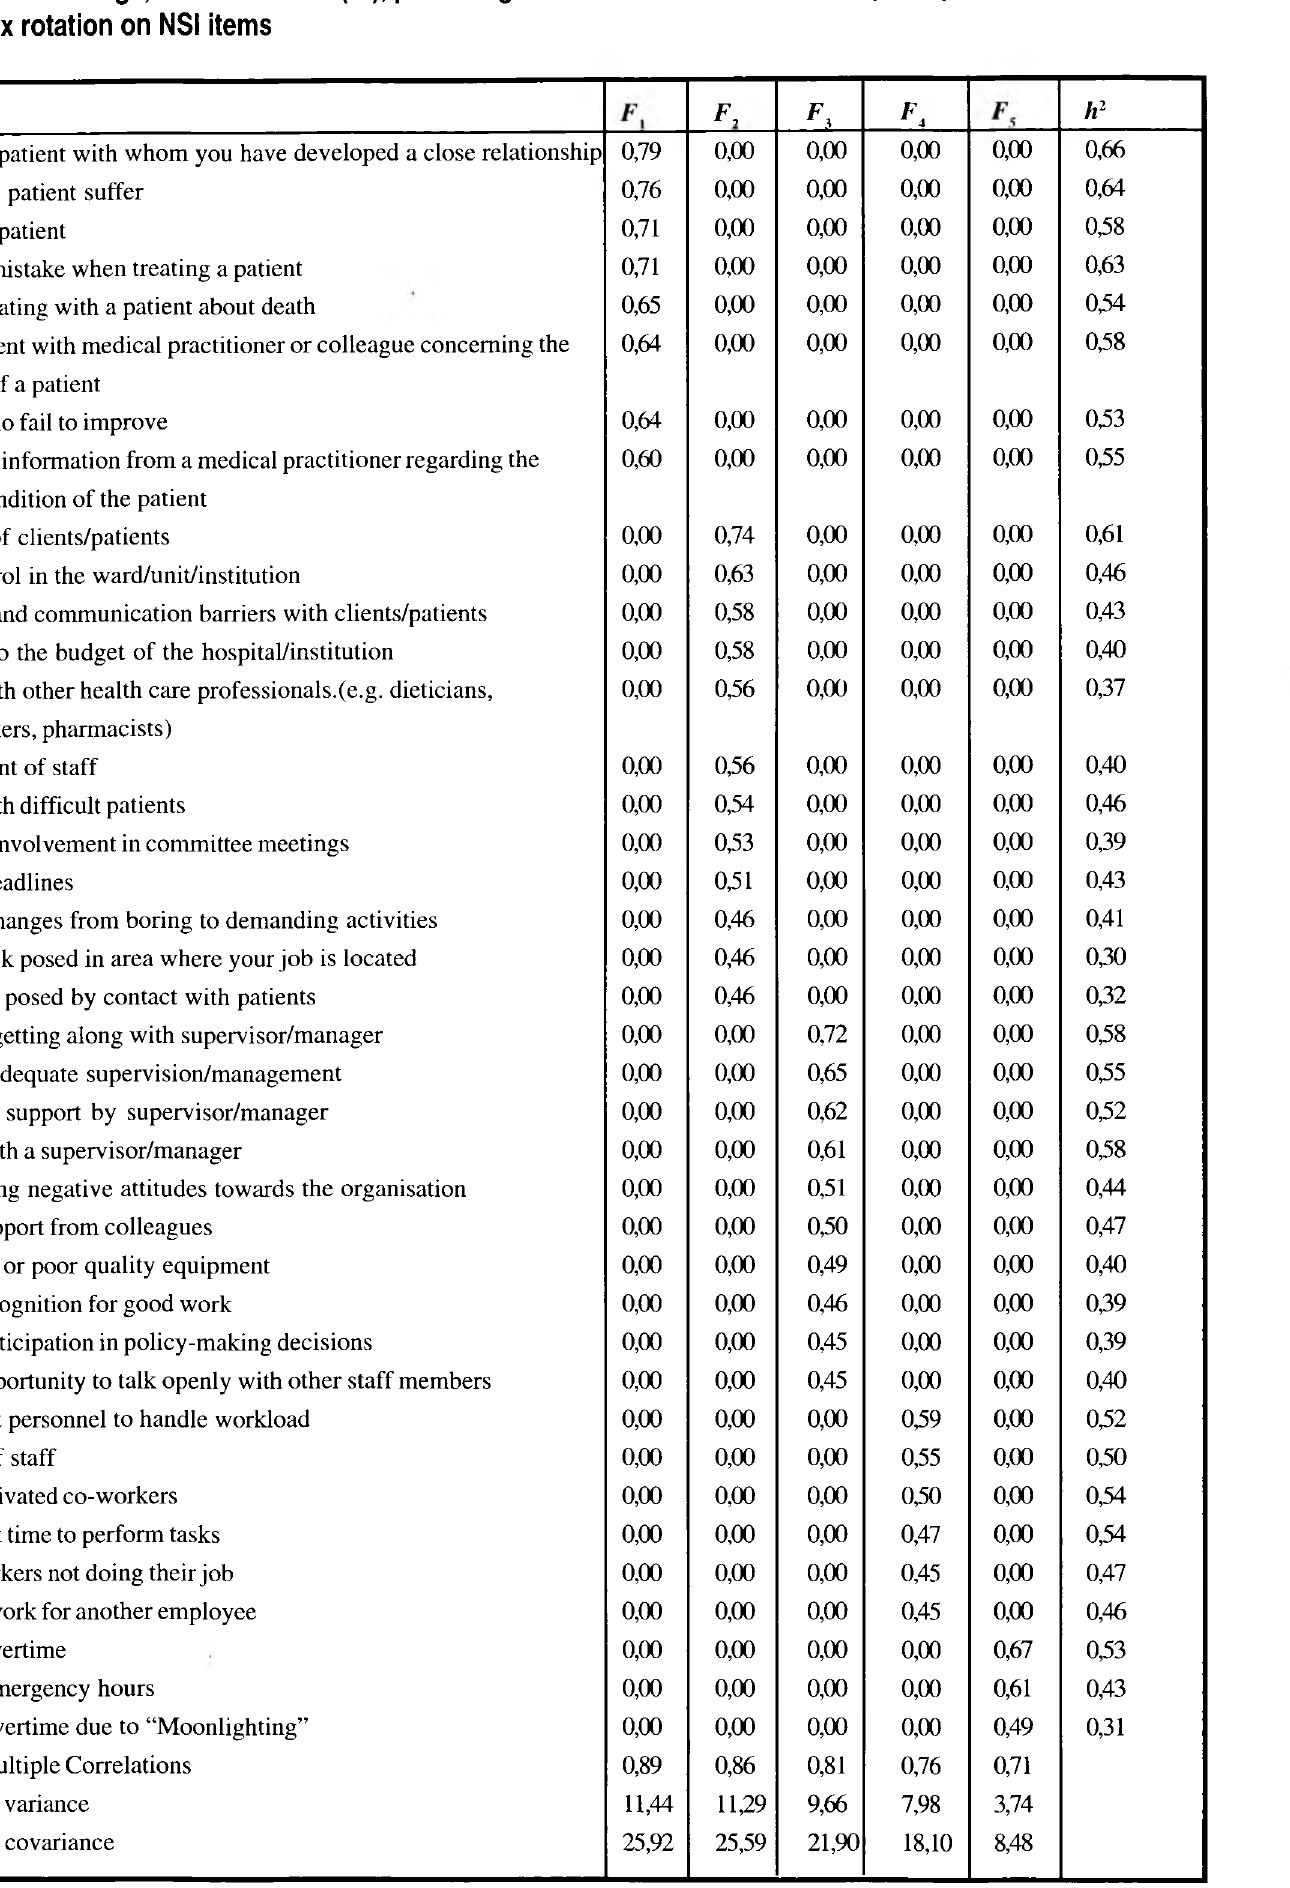
Table 2 Factor loadings, communalities {If), percentage variance and covariance for principal factor extraction and varimax rotation on NSI